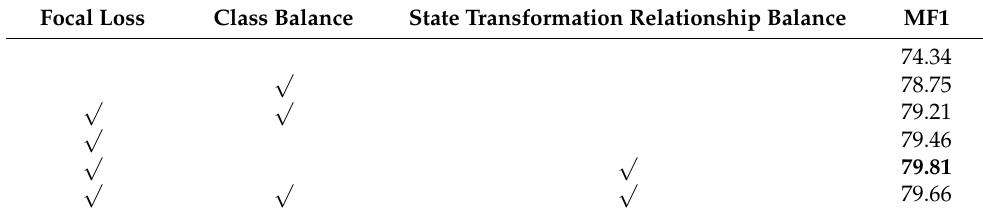
Table 6. The impact of nonrelational inductive biases on network